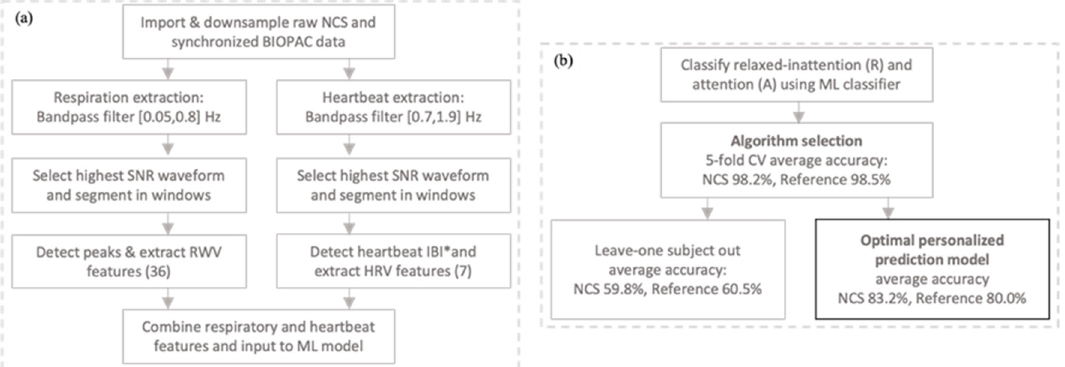
Figure 6. Flow charts representing our signal processing and ML system architecture. ( a ) Signal processing and feature extraction. * IBI is extracted from second harmonic heartbeat, requiring re-filtering of the highest SNR waveform around the dominant HR frequency; ( b ) ML model validation process.